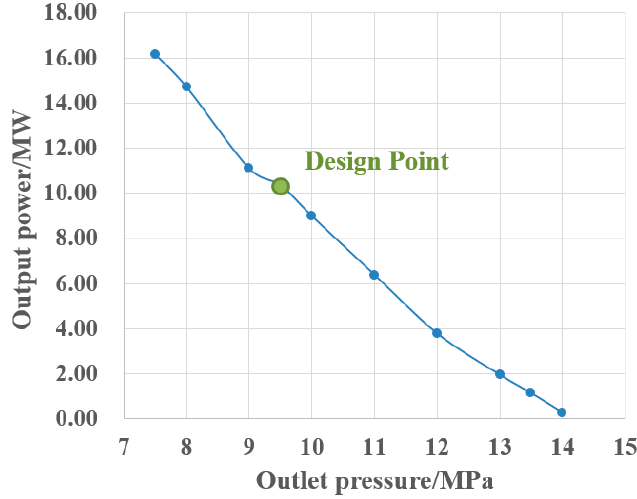
Figure 11. The variation curve of turbine output power with outlet static pressure.